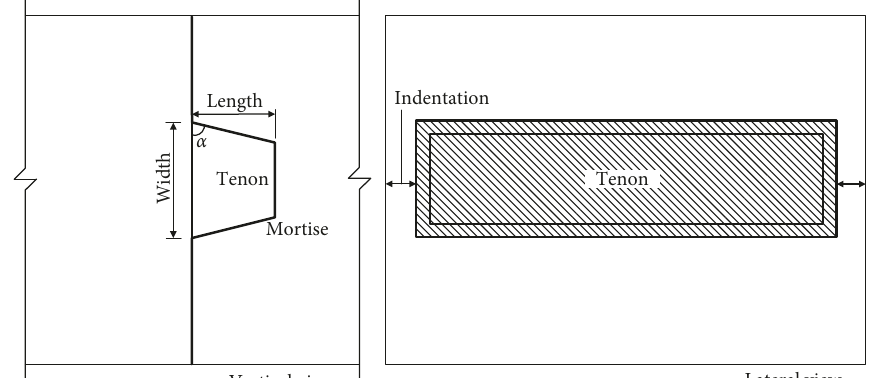
Figure 4: Geometric design of a mortise and tenon joint.